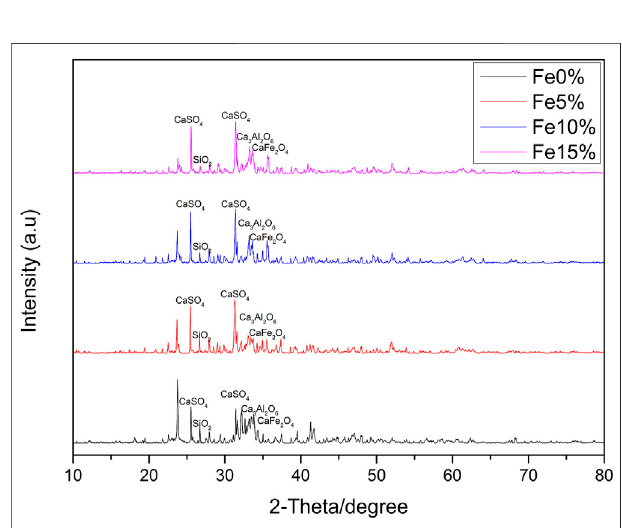
FIGURE 4 | XRD spectra of Fe based composite catalysts with different Fe load